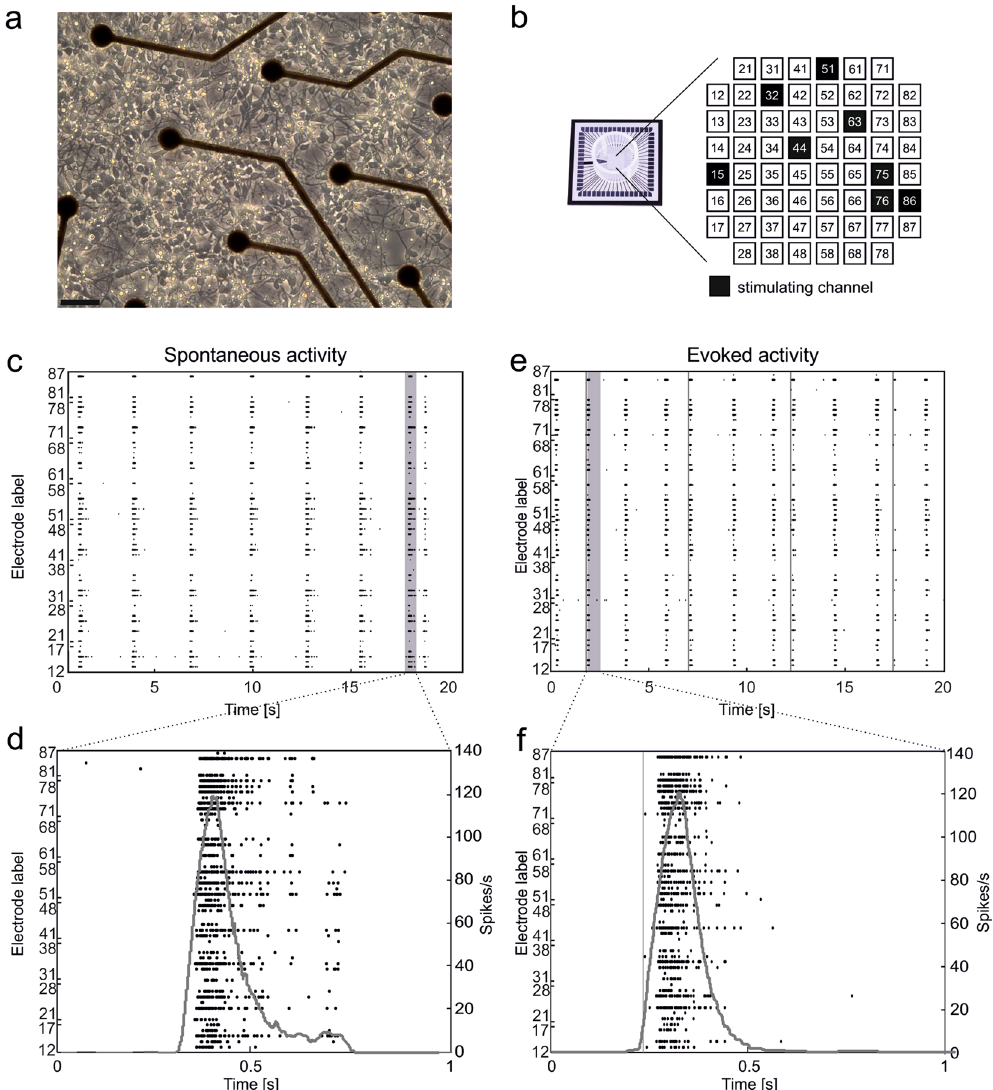
Figure 1. Cortical cultures over MEAs show both spontaneous and evoked synchronized network bursts. ( a ) Optical micrograph (magnification 10 x ) of a culture of dissociated rat cortical neurons plated over a MEA at 3 DIV (spatial calibration bar 50 µ m). ( b ) Sketch illustrating the geometrical layout of a MEA (shown in a sample photograph on the left), including all electrodes’ labels. In each experiment, 8 different channels were selected to deliver a sequence of 100 monopolar voltage pulses at 0.2 Hz (biphasic square wave, amplitude ± 750 mV, duration 500 μ s, duty cycle 50%). ( c ) Raster plot of 20 s of spiking activity recorded by a 60-electrode MEA. ( d ) Zoom on 1 s of activity highlighting a spontaneous NB. Black dots represent the detected spikes, while the grey curve is the corresponding instantaneous firing rate function (moving rectangular window: 100 ms). ( e , f ) Same graphical notation as in ( c , d ) but during a stimulation phase. Stimuli onsets are marked by grey vertical